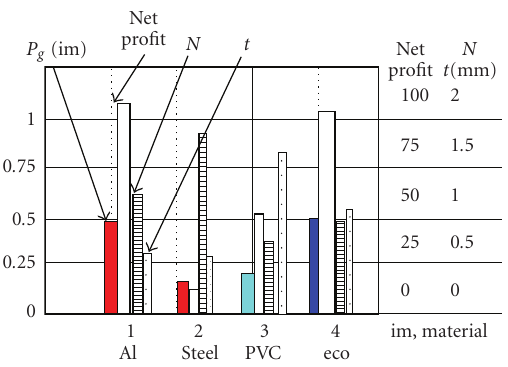
Figure 6: Results of optimisation.